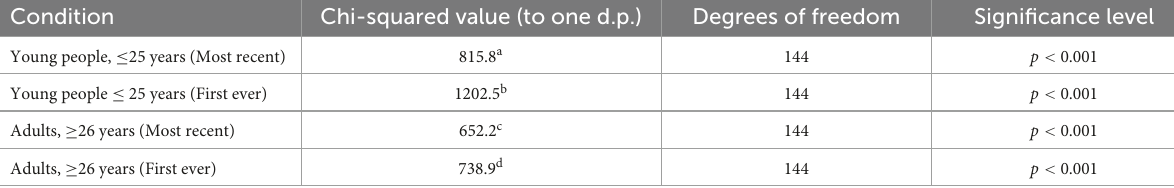
TABLE 2 The chi-squared statistic of associations between categories and time points for each group with violations reported. Condition Chi-squared value (to one d.p.)